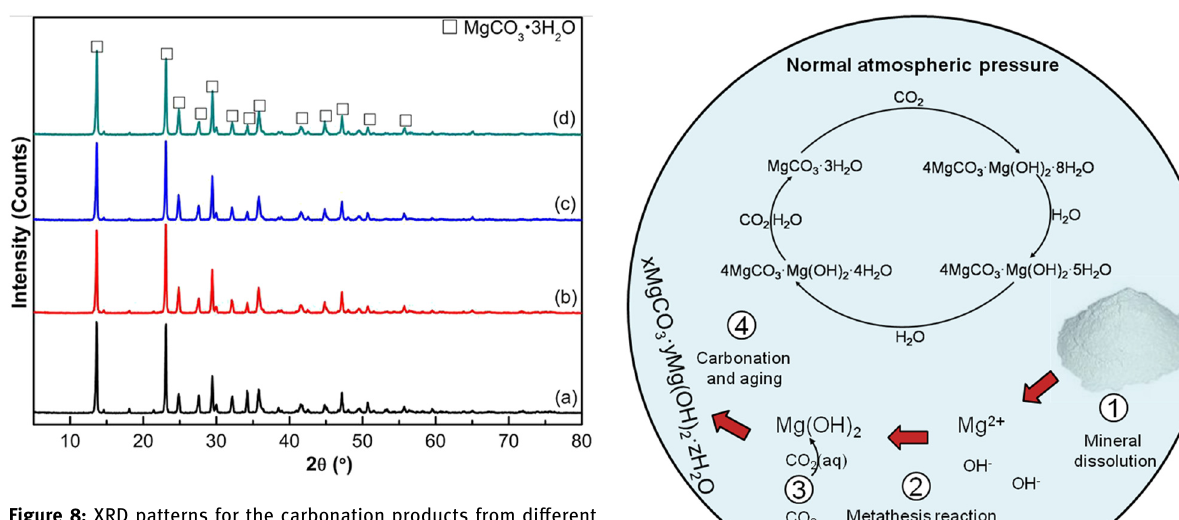
Figure 8: XRD patterns for the carbonation products from di ff erent carbonation times: ( a ) 30 min, ( b ) 60 min, ( c ) 90 min and ( d ) 120 min.